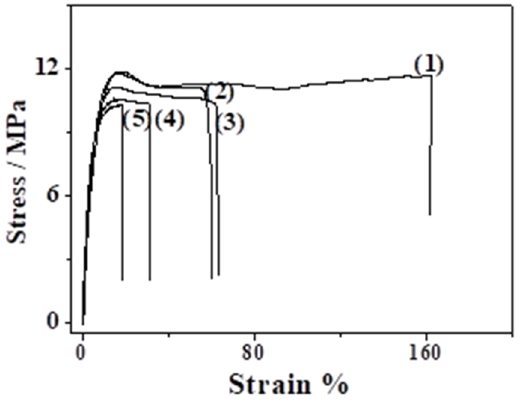
Figure 6. Strain–stress curves of (1) LDPE, (2) LDPE/CS_BO5, (3) LDPE/CS_BO10, (4) LDPE/CS_BO20, and (5) LDPE/CS_BO30.